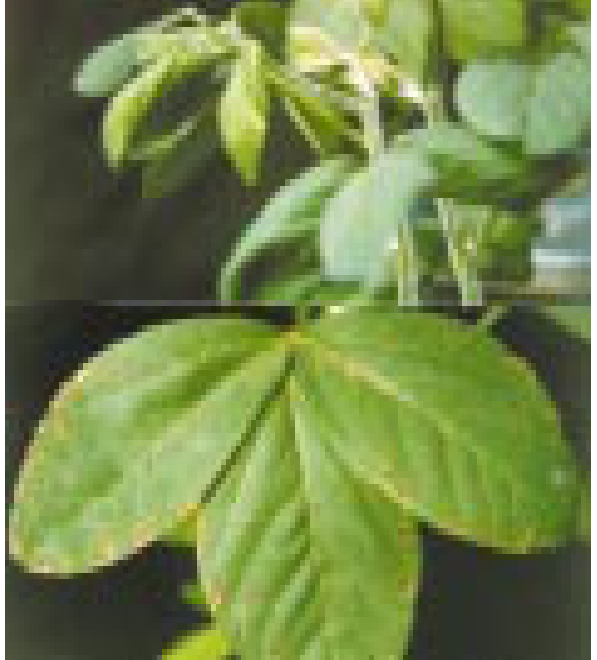
Figura 1. Sintomas observados de deficiência (acima) e toxidez (abaixo) de B em folhas de soja, respectivamente, nos tratamentos com 0,0 e 2,0 mg L -1 de B na solução